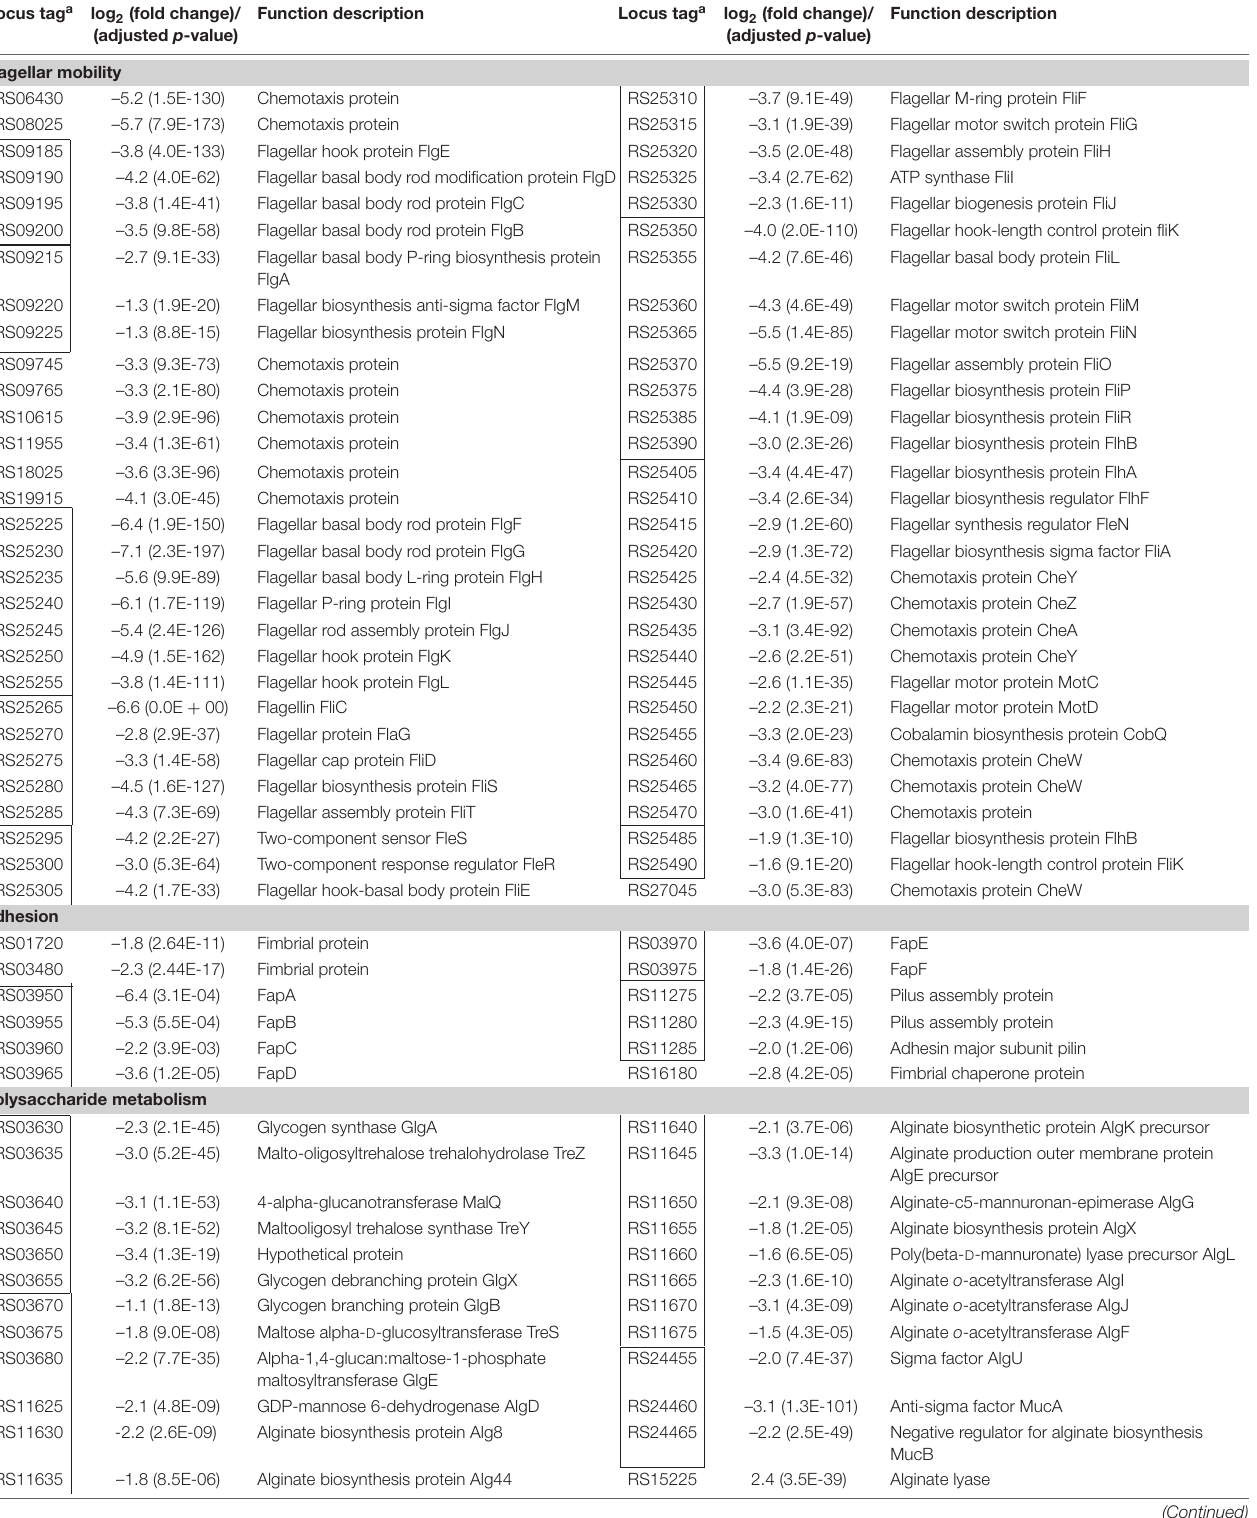
TABLE 2 | Representative genes differentially expressed in the rpoN mutant compared with the wild-type strain UK4. Locus tag a log 2 (fold change)/ Function description Locus tag a log 2 (fold change)/ (adjusted p -value)